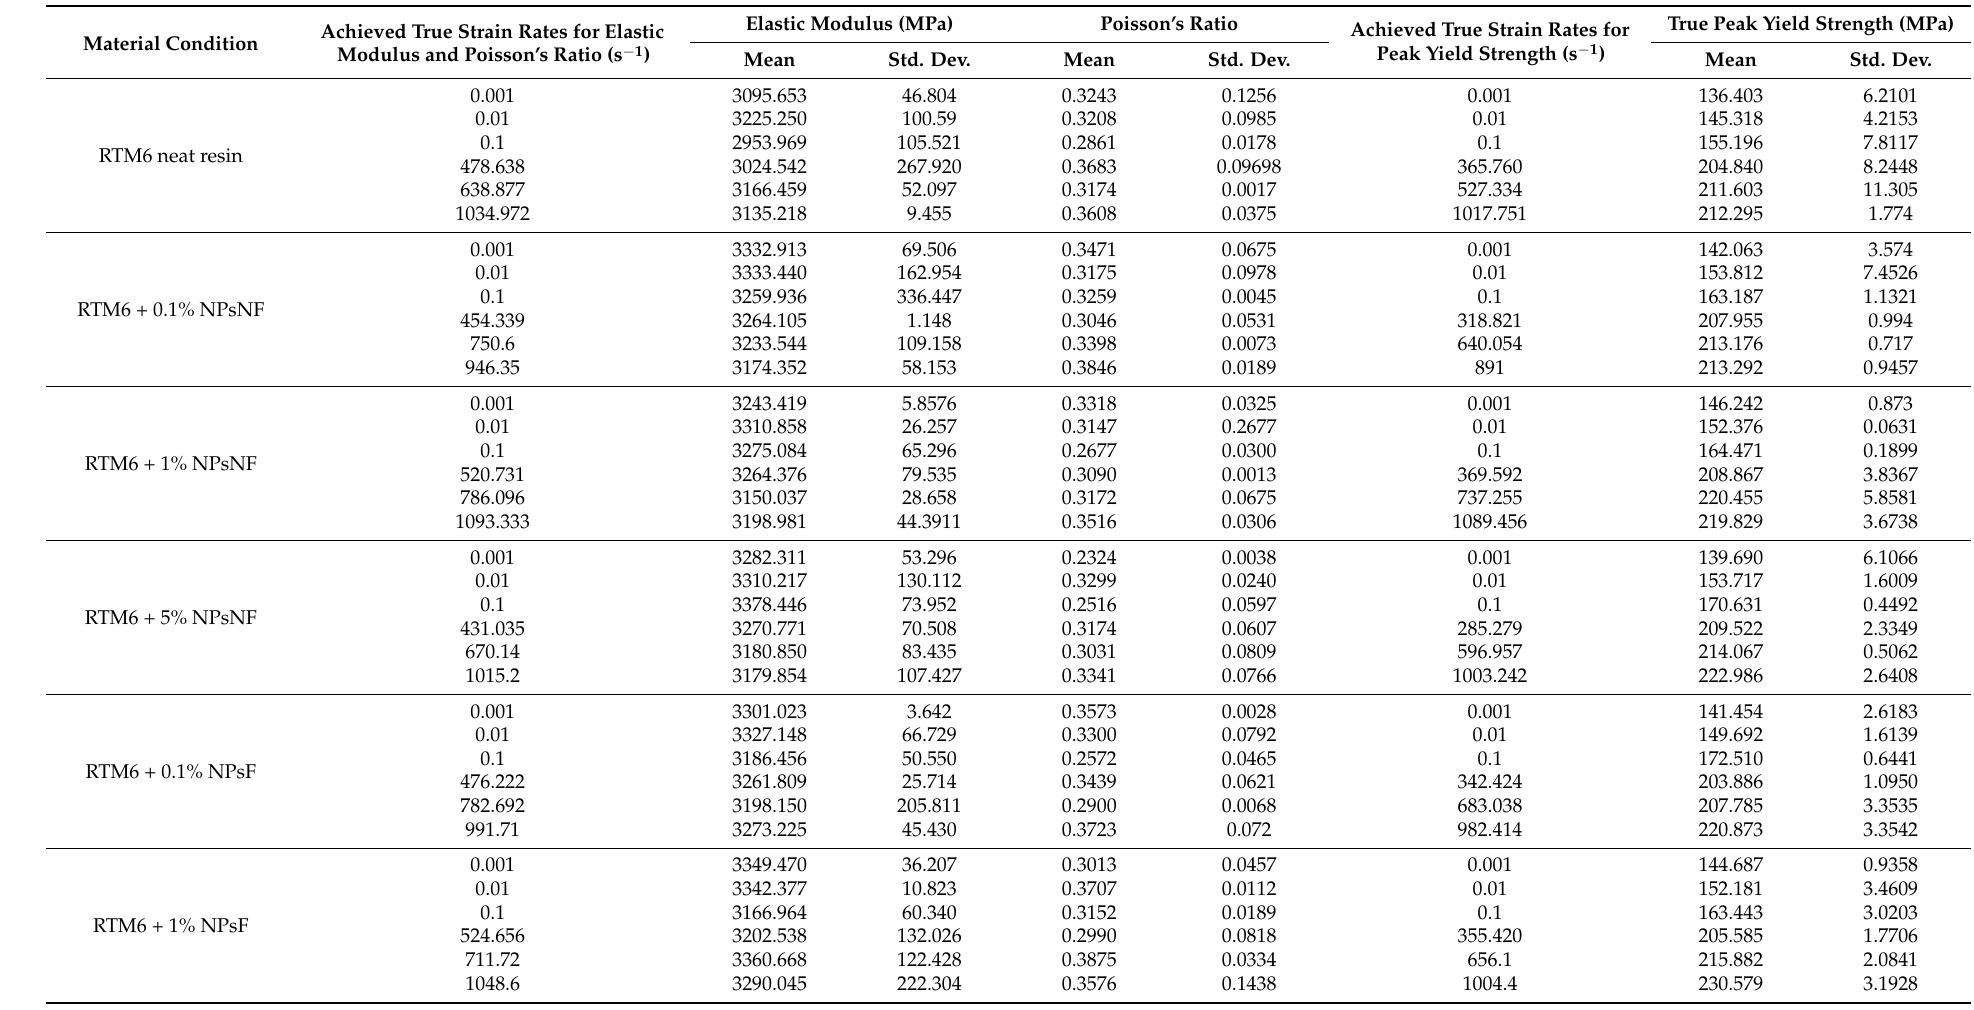
Table 4. Summary of the results of the neat RTM6 and RMT6/ silica epoxy nanocomposite (functionalized and non-functionalized) during compression at different strain rates. Material